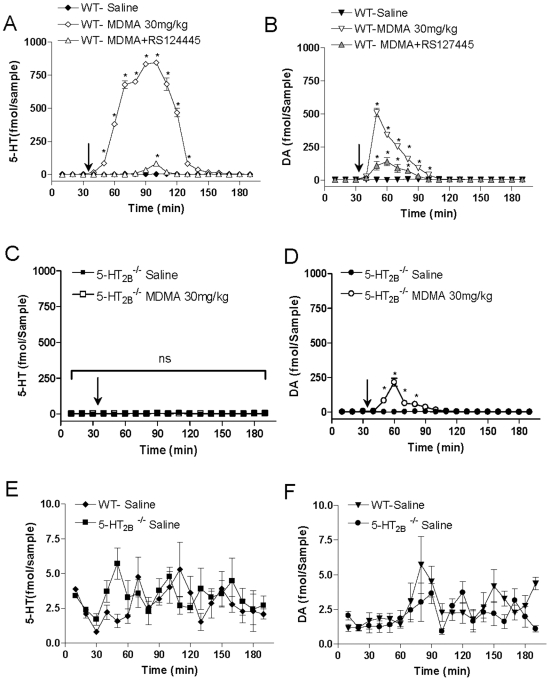
Effect of 5-HT2B receptor inhibition on MDMA (30 mg/kg) - evoked increase in NAcc 5-HT and DA levels as measured by in vivo microdialysis in awake mice.Effect of MDMA (30 mg/kg i.p.) or saline injection on (A) 5-HT, (B) DA concentrations in dialysates from the NAcc of WT or RS127445 (0.5 mg/kg i.p.)-WT pre-treated mice. Effect of 5-HT2B receptor genetic ablation on MDMA (30 mg/kg)-induced changes in (C) 5-HT or (D) DA levels in NAcc. MDMA or saline solutions were injected 35 minutes after test began (arrow). Basal 5-HT and DA extracellular levels are reported at lower scale in E) and F) respectively for WT and 5-HT2B-/- mice. Data (means±SEM, n = 4−5 per group) were analyzed by two-way ANOVA (repeated measures) with RS-administration or genotype and time as main factors. A significant interaction was observed after 5-HT2B receptor pharmacological inhibition (RS127445) (A–B) for 5-HT levels F (36,180) = 429.5 p<0.001 as well as for DA levels F (36,180) = 82.43, p<0.001. A main effect of RS-treatment was observed for 5-HT levels F (2, 180) = 3677, p<0.001 and for DA levels F (2, 180) = 449.7, p<0.001, whereas a main effect of time was also detected for 5-HT levels F (18, 180) = 498.1, p<0.001 and for DA levels F (18, 180) = 166.5, p<0.001. For 5-HT2B-/- mice (C–D), a significant interaction was not observed for 5-HT levels F (18,126) = 1.33, ns, but it was the case for DA levels F (18,126) = 53.98, p<0.001. Neither a main effect of genotype F (1, 126) = 0.36, ns, nor of time F (18, 126) = 1.08, ns, was observed for 5-HT levels. On the contrary, a main effect of genotype F (1, 126) = 363.3, p<0.001, as well as of time F (18, 126) = 53.55, p<0.001 was detected for DA levels. Bonferroni tests were used for post-hoc comparisons. The null hypothesis was rejected at the p<0.05 level; *p<0.001.